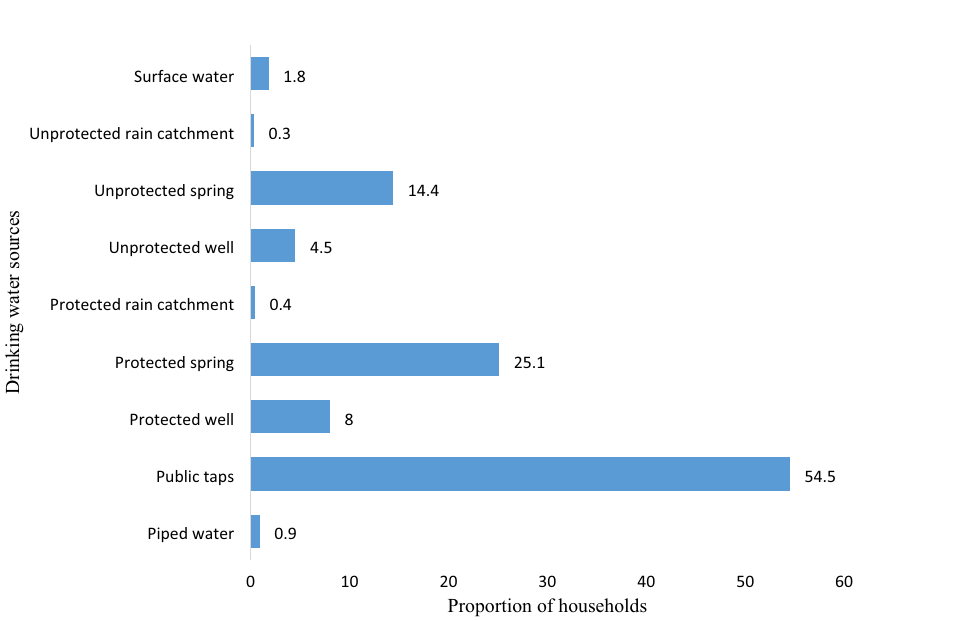
Figure 2. Drinking water sources for households (n = 1190) in a rural setting of northwest Ethiopia, May